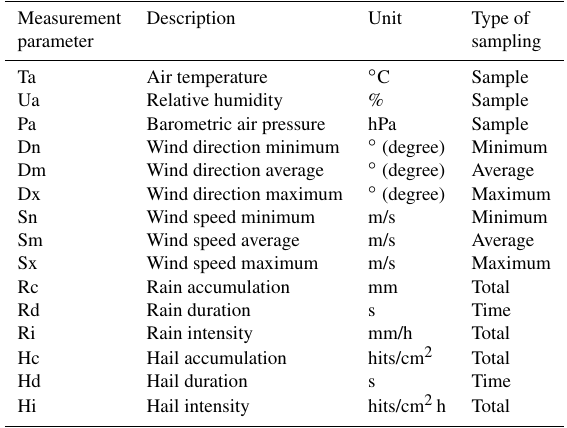
Table 5. List of meteorological parameters measured by the com- pact weather transmitter (station type